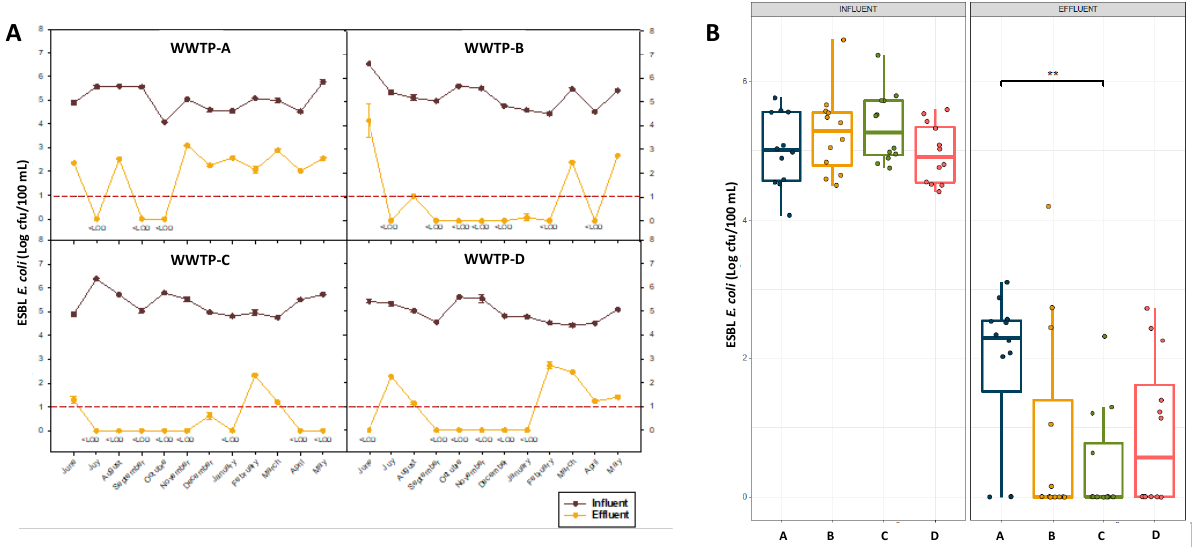
Figure 2. Spatio-temporal ( A ) and spatial ( B ) distribution of ESBL-producing E. coli (log cfu/100 mL) in influent and effluent samples for all four WWTPs between June 2020 and May 2021. In the boxplot, the solid horizontal line represents the median, and the box displays the 25 – 75% quartile range. Only significant p values ( p < 0.05) obtained from the Wilcoxon signed-rank test analysis are indicated (**).